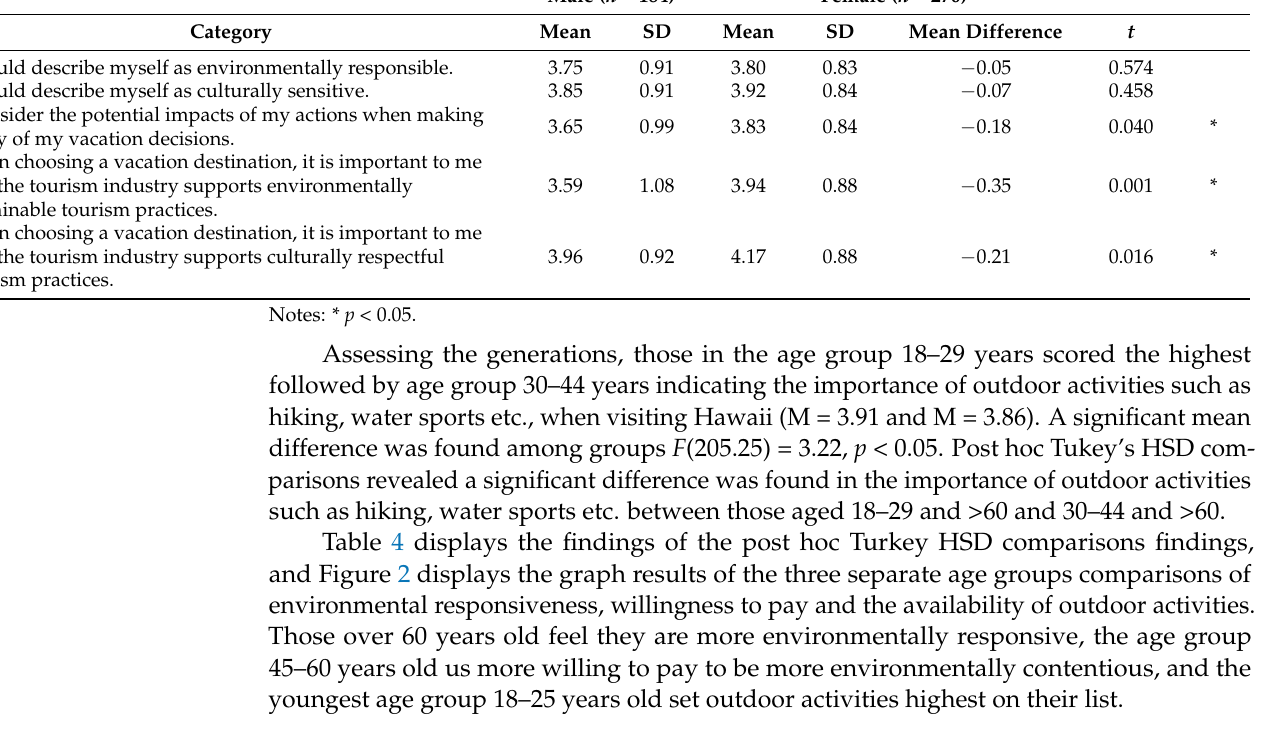
Table 4. Significant differences among